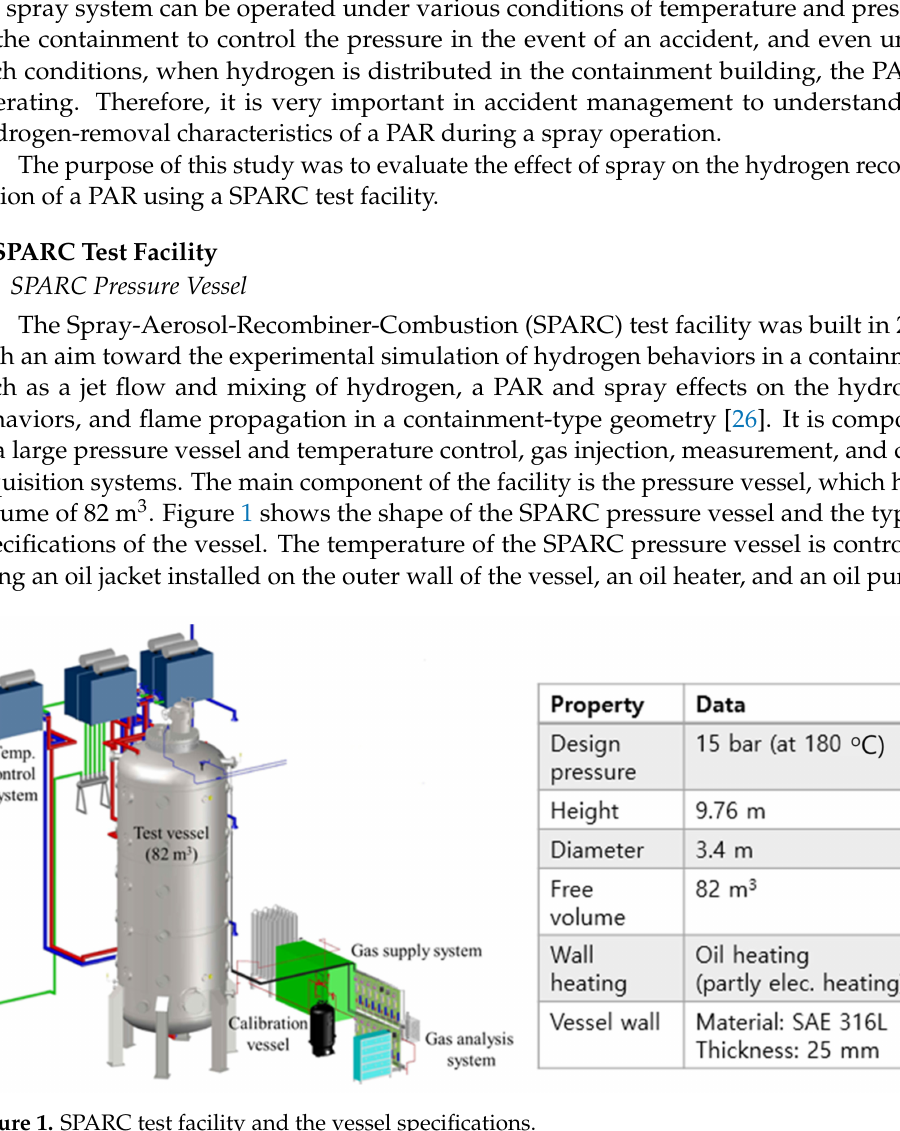
Figure 1. SPARC test facility and the vessel